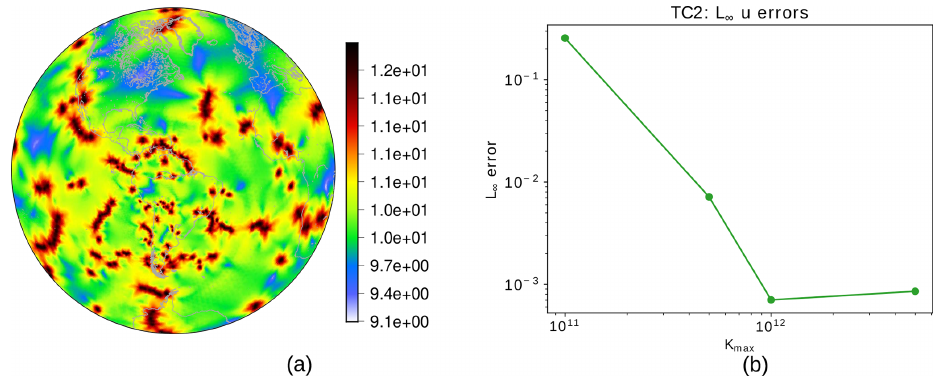
Figure 8. Hyperdiffusion coefficient (in log10 scale) based on the smoothed alignment index for each cell in the VR7 grid (a) and L ∞ error of the normal component of the velocity field for different values of K max considering the steady geostrophic flow test case for the VR7 grid (b)